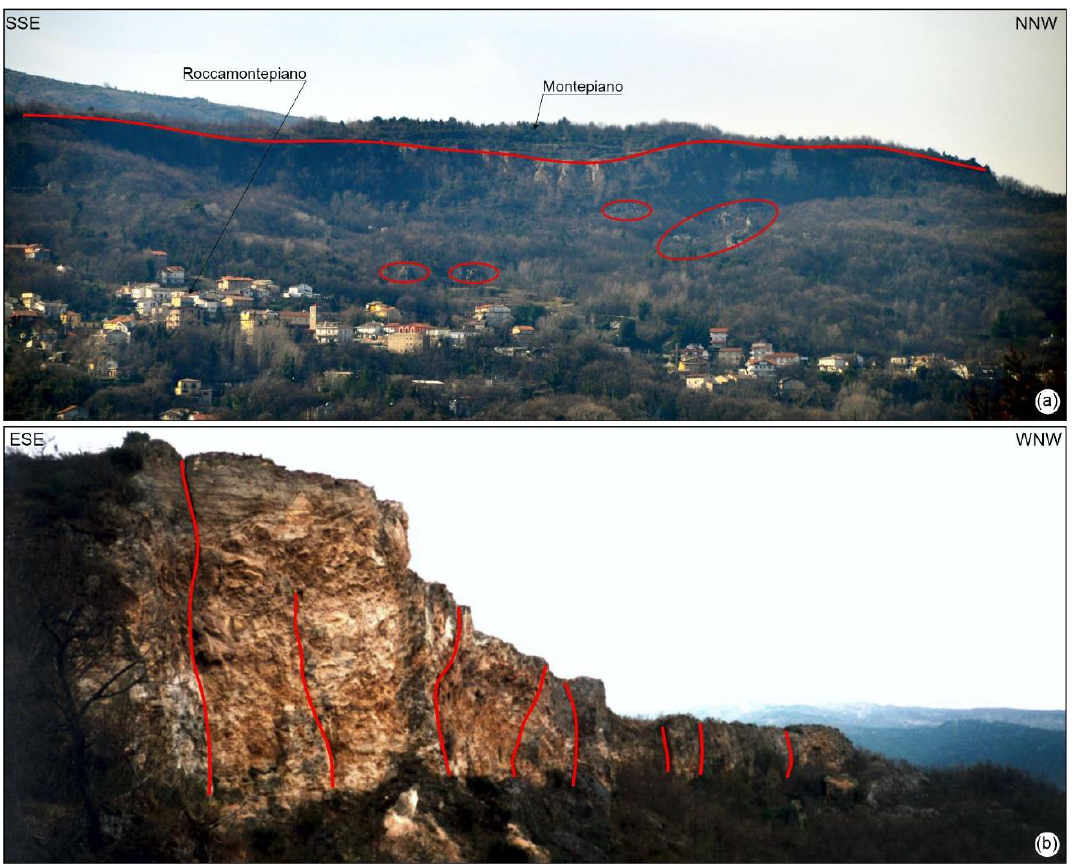
Figure 9. Photo documentation of geomorphological features of Roccamontepiano landslide. ( a ) Panoramic view of the landslide area. Red lines show the planimetric development of main landslide scarps, red circles show travertinous blocks in the landslide body; ( b ) detail of NE–SW trending traction fractures (red lines) in the travertine cliff scarp near Ripa Rossa.